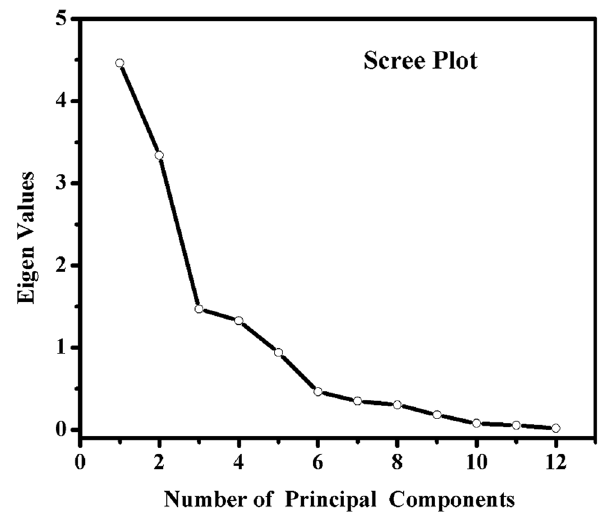
Fig. 2 Scree plot representing the eigenvalues and the proportion of explained variance accounted for by the principal